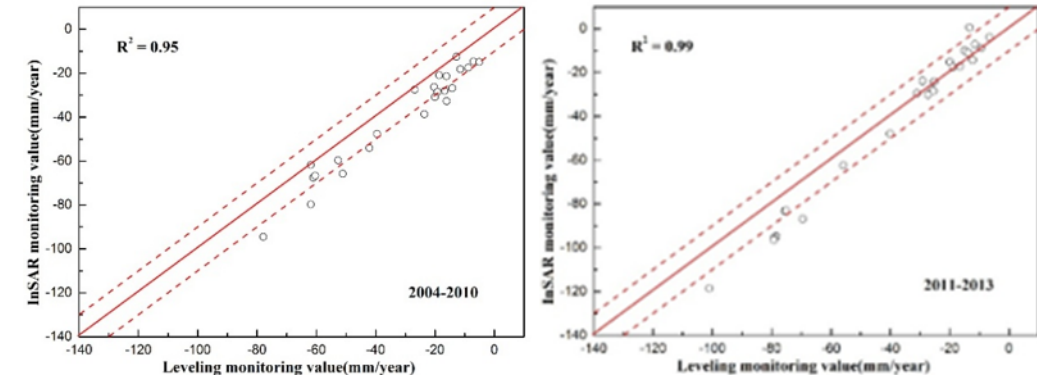
Figure 4. The validation map between InSAR and benchmarks from 2003 to 2013.